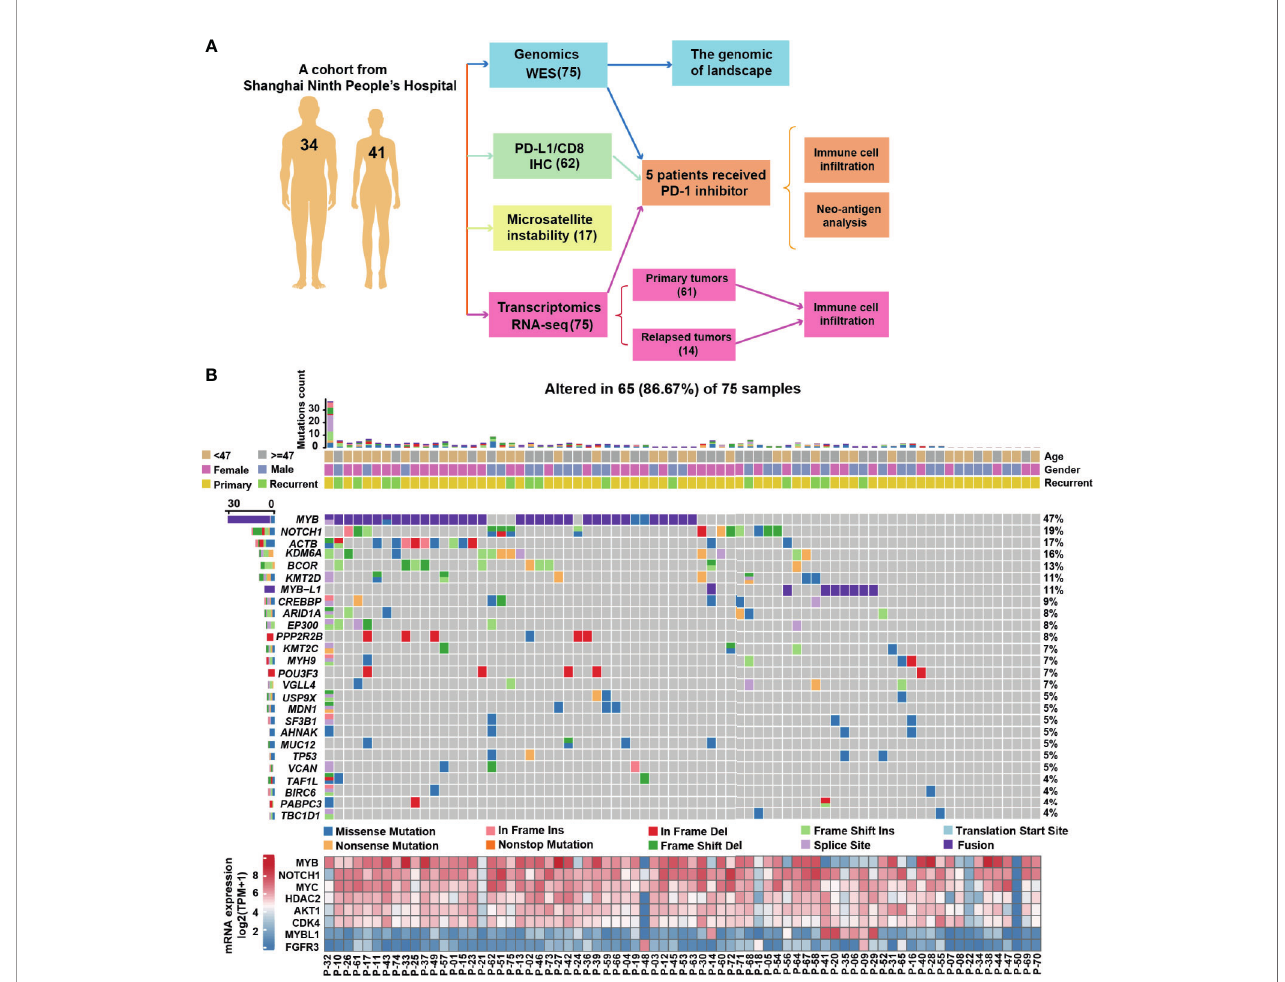
FIGURE 1 | The genomic landscape of adenoid cystic carcinoma. (A) Work fl ow of genetic hallmarks and immune-in fi ltrate pro fi ling in ACC patients. (B) Mutation rate and type, age, gender, and surgical outcomes. Ten tumor samples were undetectable of any variant with allele frequencies (AFs) ≥ 1%. Bottom panel, RNA expression level for selected genes, expressed as log 2 (TPM + 1) for all samples. TPM, transcripts per million (TPM) expression